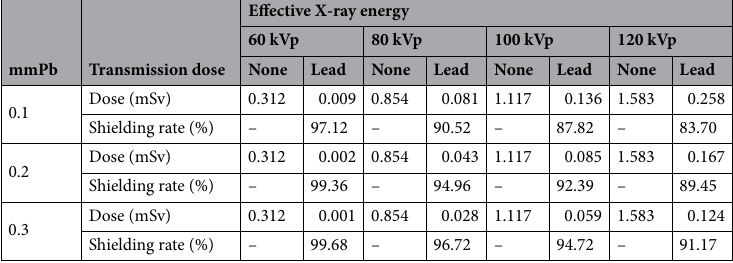
Table 3. Shielding performance evaluation of standard lead plates.